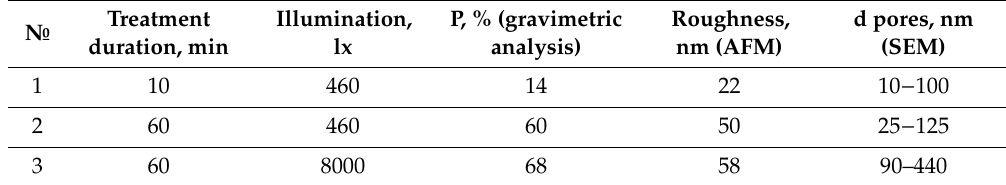
Table 2. The roughness and the pore diameters of black and brown silicon.